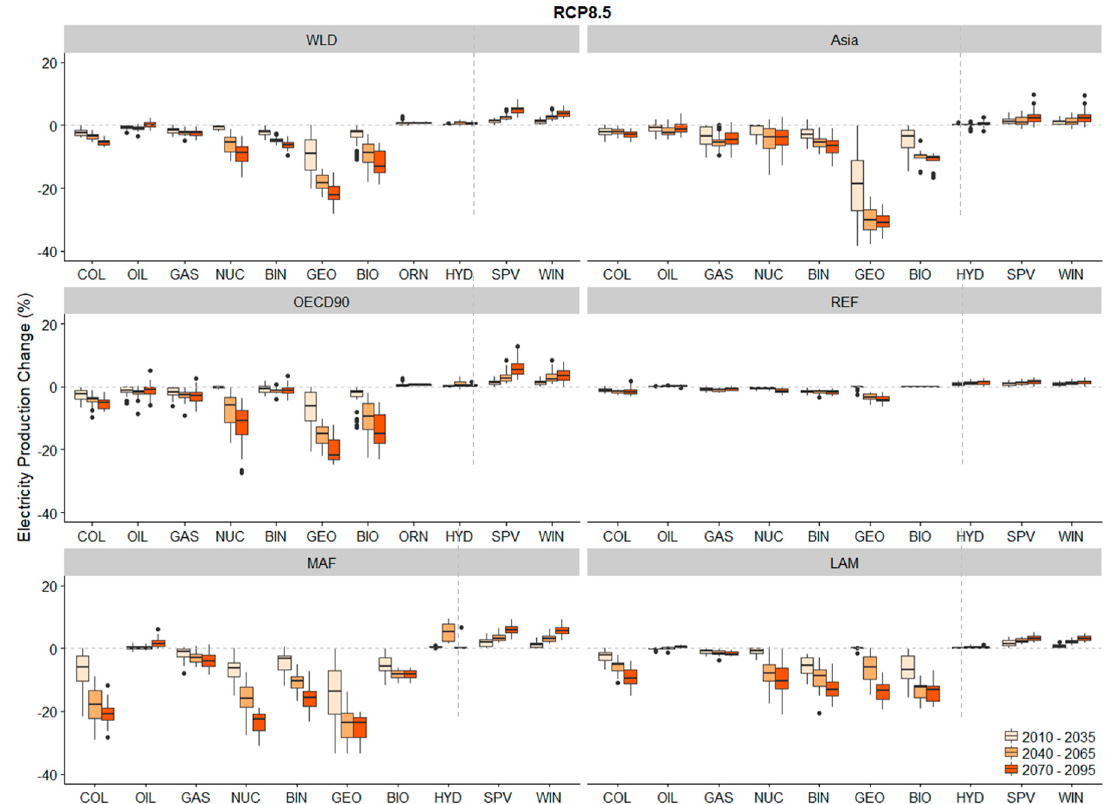
Figure 4. Differences in electricity production between the RCP2.6 and NoCC runs. The results of thermal and non-thermal sectors in three periods (2010–2035, 2040–2065, and 2070–2095) are shown. The range shows the variations in time and the differences among the five global climate models (GCMs).